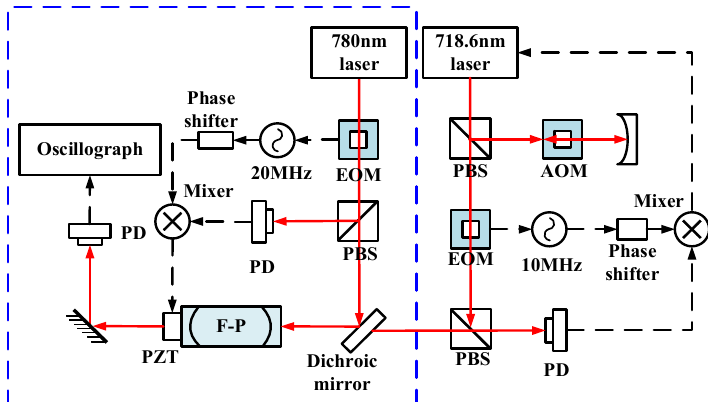
Figure 8. Schematic illustration of the frequency stabilization system with a transfer cavity. EOM: electro–optic modulator; AOM: acousto–optic modulator; PBS: polarizing beam splitter; PD: photo detector; PZT: piezoelectric transducer. (Figure reproduced from [65].)